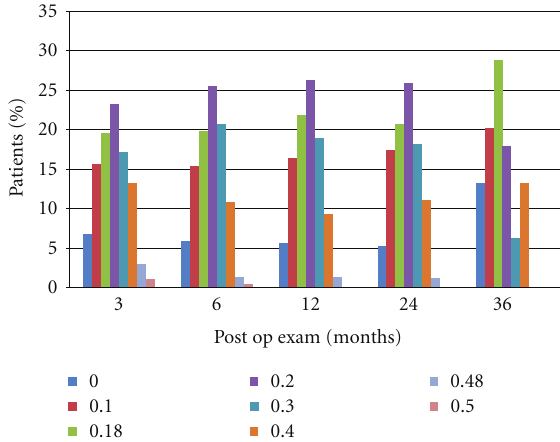
Figure 4: Post-op UIVA in di ff erent periods of